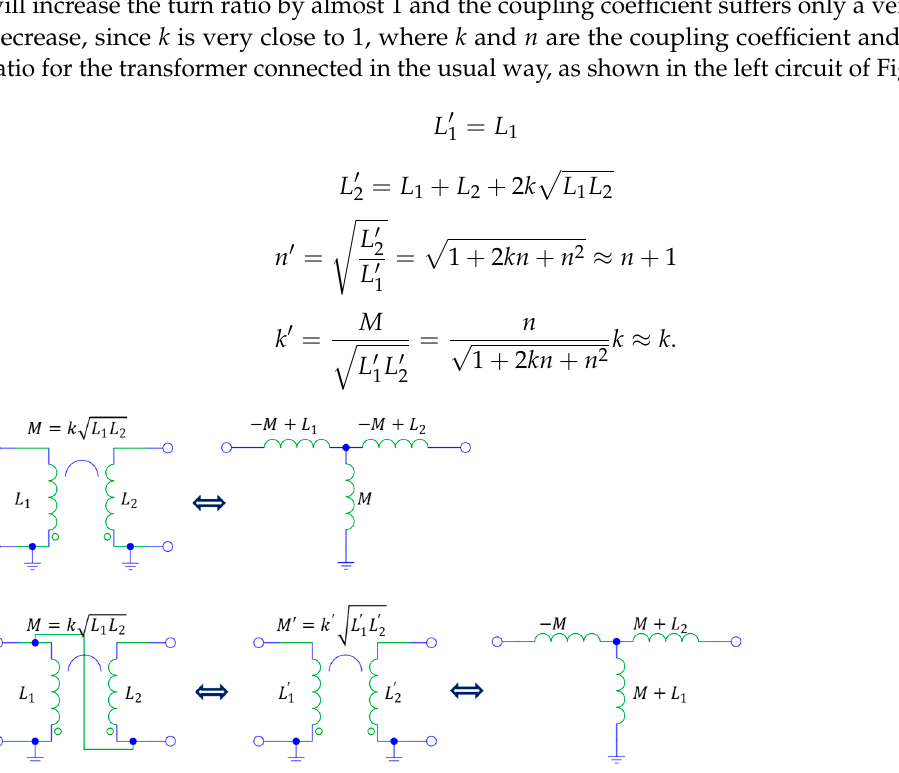
Figure 7. Structure of the partial core transformer. ( a ) Cross-section of the Transformer; ( b ) The cone skeleton made of cardboard.